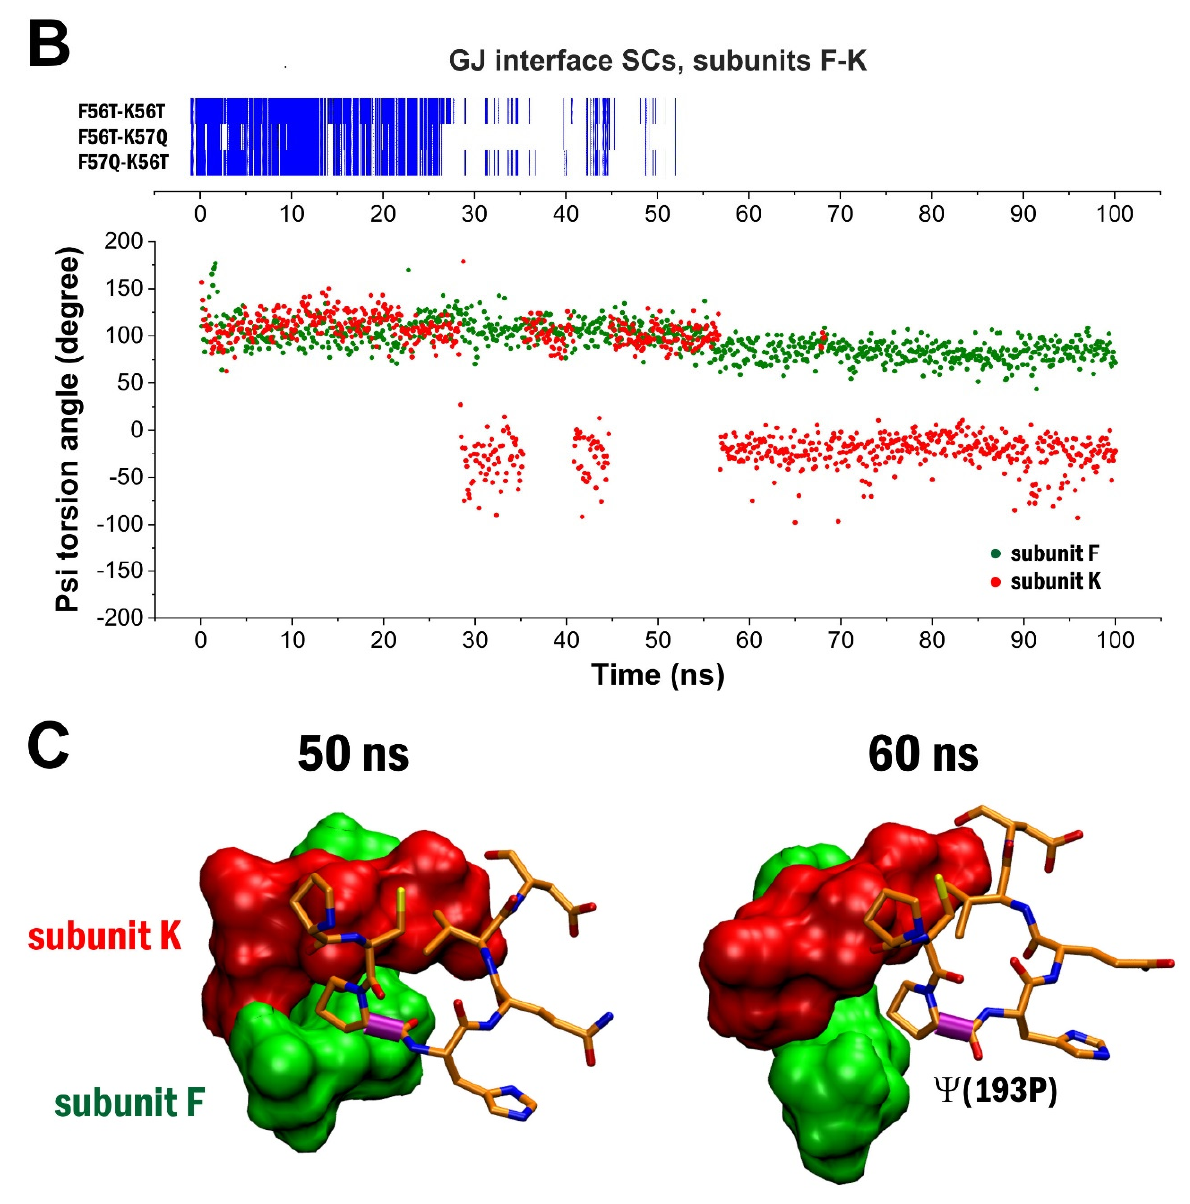
Figure 5. Appearance of GJ interface SCs coupling of opposing connexons by 55 N -56 T -57Q correlates with the ψ torsion angle of the nearby 193 P residue. ( A ) Dynamics of GJ interface SCs between the D and G subunits during the closed disulfide MD run of Cx43 GJC (top) and the changes in the ψ (psi) torsion angle of 193 P in both subunits. ( B ) Dynamics of GJ interface SCs between the F and K subunits during the closed disulfide MD run of Cx43 GJC (top) and the changes in the ψ (psi) torsion angle of 193 P in both subunits. ( C ) 55 N , 56 T and 57Q residues (shown by surface representation) constitute the GJ interface stabilization centers (SCs) between the opposing subunits F (green) and K (red). The GJ interface SCs disappear in conjunction with the reorientation of the interface shaped by the 191–197 residues of the EL2 of subunit K. Color code: green–subunit F; red–subunit K. The ψ torsion angle of the 193 P residue of subunit F is highlighted by a purple